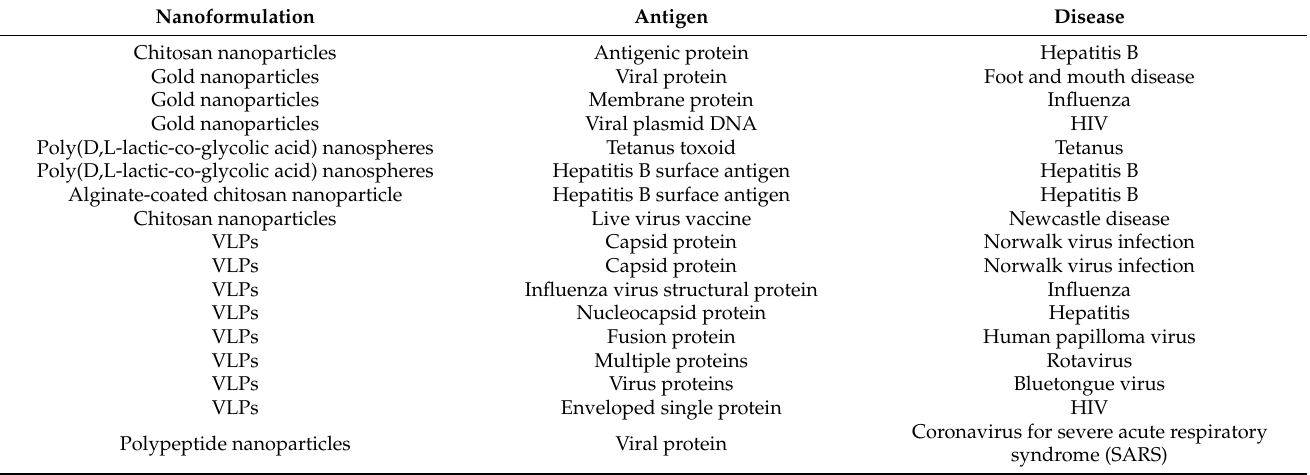
Table 2 describes potential nanoformulations to be used as viral antigen carriers. Table 2. Potential nanoformulations to be used as viral antigen